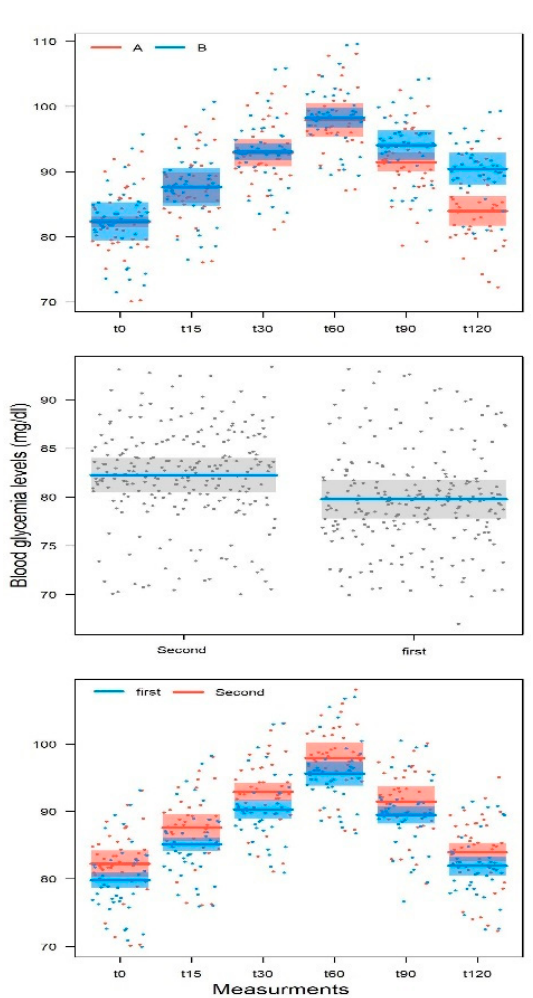
Figure 3. Variation in postprandial glycaemia for the two experimental treatments. Above : variation in blood glucose for the two experimental treatments (A: BSG extract-based food supplement and